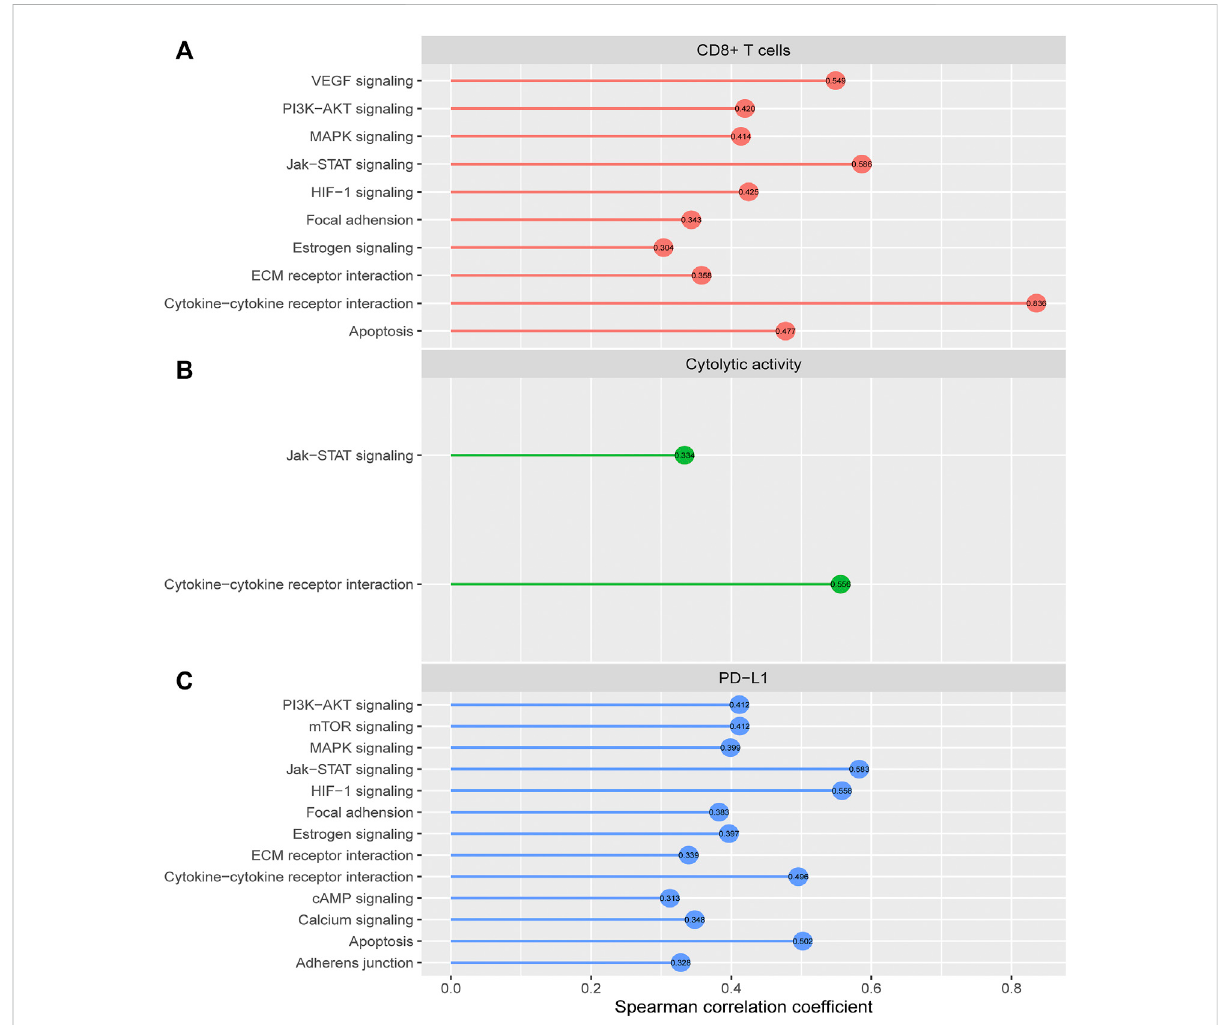
FIGURE 6 Cancer-associatedpathwayswhoseenrichmentissigni fi cantlycorrelatedwithCD8 + Tcellenrichment,cytolyticactivity,or PD-L1 expressionin HCC. The cancer-associated pathways having signi fi cant positive correlations of their enrichment with CD8 + T cell enrichment (A) , cytolytic activity (B) , and PD-L1 expression (C) in HCC ( r >